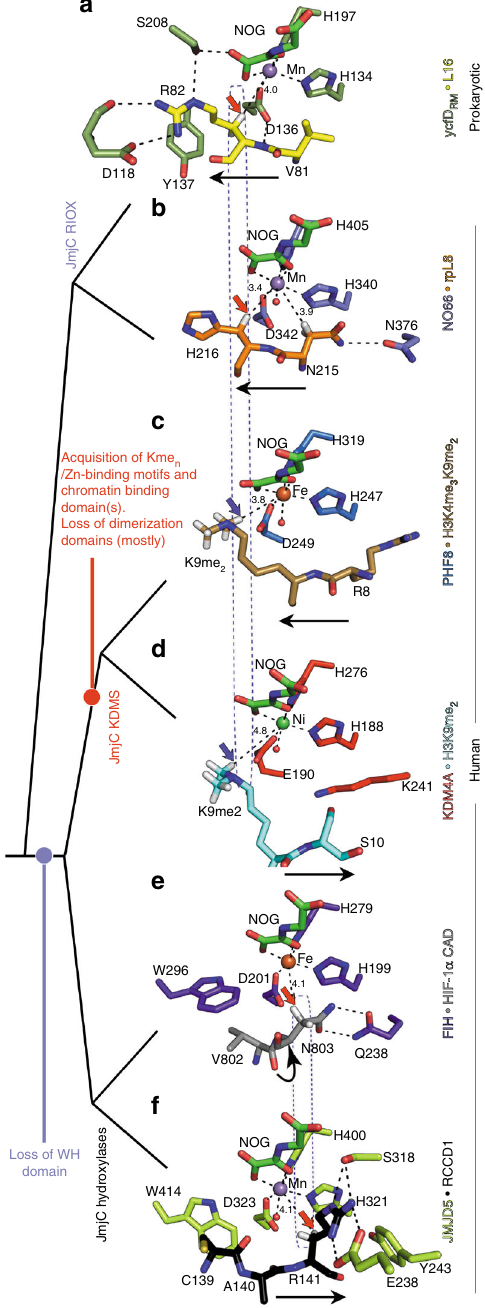
Fig. 6 Comparison of the active site substrate binding modes for JMJD5 and related JmjC enzymes. Red/blue arrows indicate hydroxylation/ demethylation sites, respectively. Active-site metals (Fe or Fe surrogates, Mn/Ni) are colour-coded spheres. Values represent distances (Å) from the metal to the oxidised carbon. a ycfD RM .Mn.NOG.L16(72 – 91) (PDB: 4CUG), b NO66.Mn.NOG.RPL8(205 – 224) (PDB: 4CCO), c PHF8.Fe.NOG. H3K4me 3 K9me 2 (2 – 25) (PDB: 3KV4), d KDM4A.Ni.NOG.H3K9me 2 (7 – 14) (PDB: 2OX0), e FIH.Fe.NOG.HIF-1 α (786 – 826) (PDB: 1H2K), f JMJD5.Mn. NOG.RCCD1(139 – 142) (PDB: 6F4R). Note variations in the N - to C - substrate directionality in the active site cleft (indicated by black arrows), and variations in the hydroxylation site relative to the metal